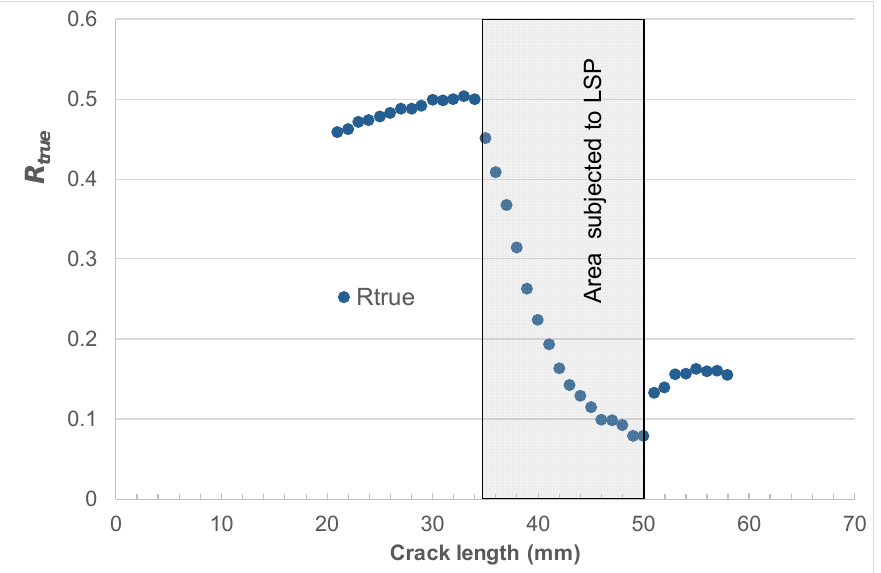
Figure 7. The relationship between an effective R ratio ( R true ) and the crack length for the LSP study reported in [75].